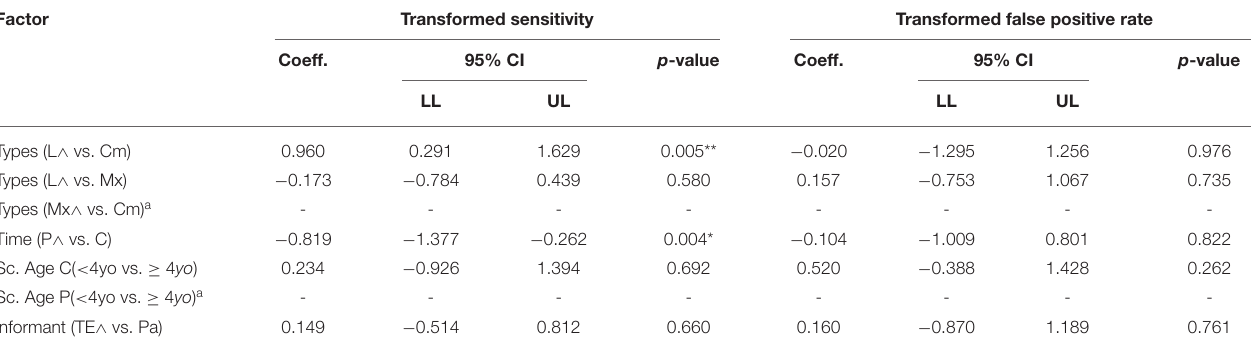
TABLE 8 | Bivariate meta-regression of study-related factors on sensitivity and false-positive rate excluding high ROB studies. Factor Transformed sensitivity Transformed false positive rate Coeff. 95% CI p -value Coeff. 95% CI p